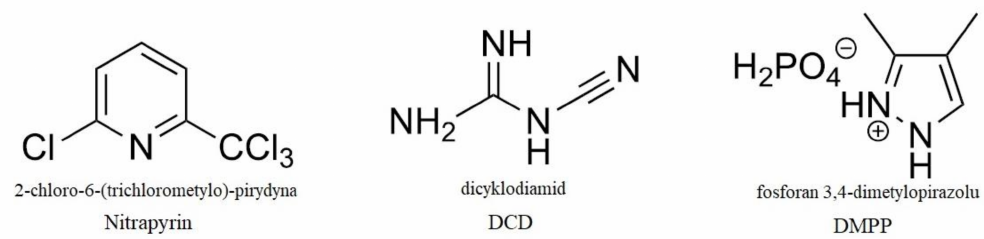
Figure 1. Nitrification inhibitors